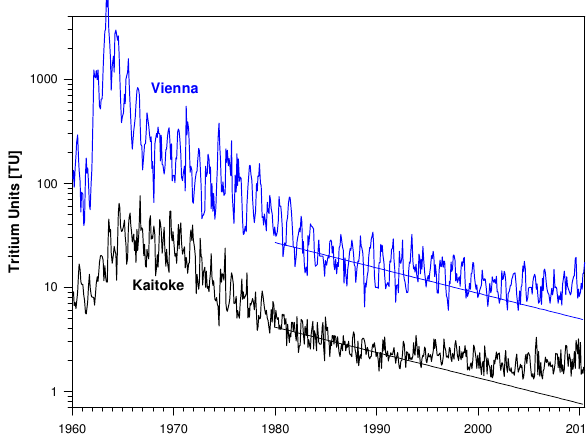
Fig. 1. Tritium in precipitation. The rain record for the Southern Hemisphere is from Kaitoke, New Zealand, and that for the North- ern Hemisphere is from Vienna, Austria. Data for Vienna are from Global Network of Isotopes in Precipitation (GNIP), with data for recent years from Manfred Groening, IAEA (personal communica- tion, 2009). One TU corresponds to an atomic ratio of tritium/total hydrogen of 10 − 18 , and a tritium concentration of 0.11919Bq/kg (Morgenstern and Taylor, 2009).